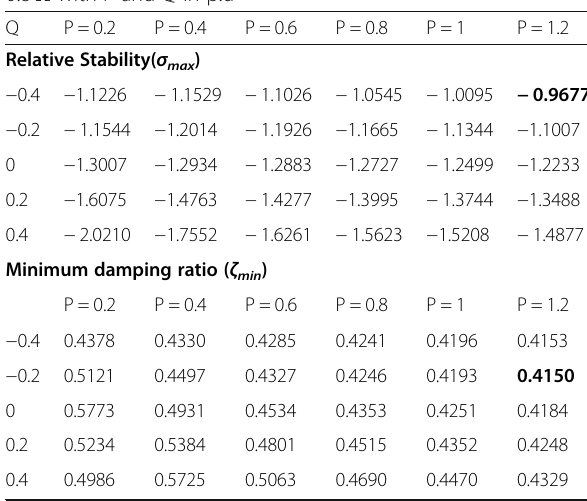
Table 2 Relative stability and minimum damping ratio for x e = 0.8 Ω with P and Q in p.u